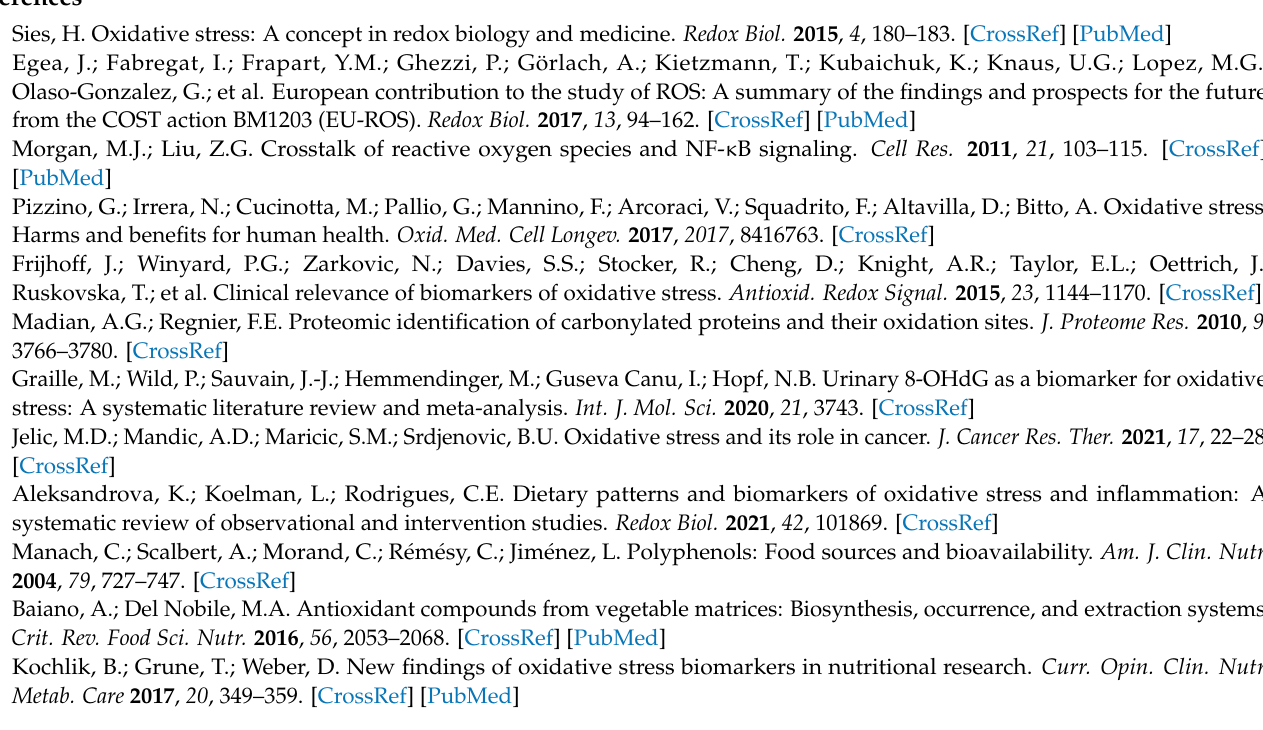
Figure S2: Scatterplot of oxidative damage biomarkers in the Finnish study, Figure S3: Scatter plots